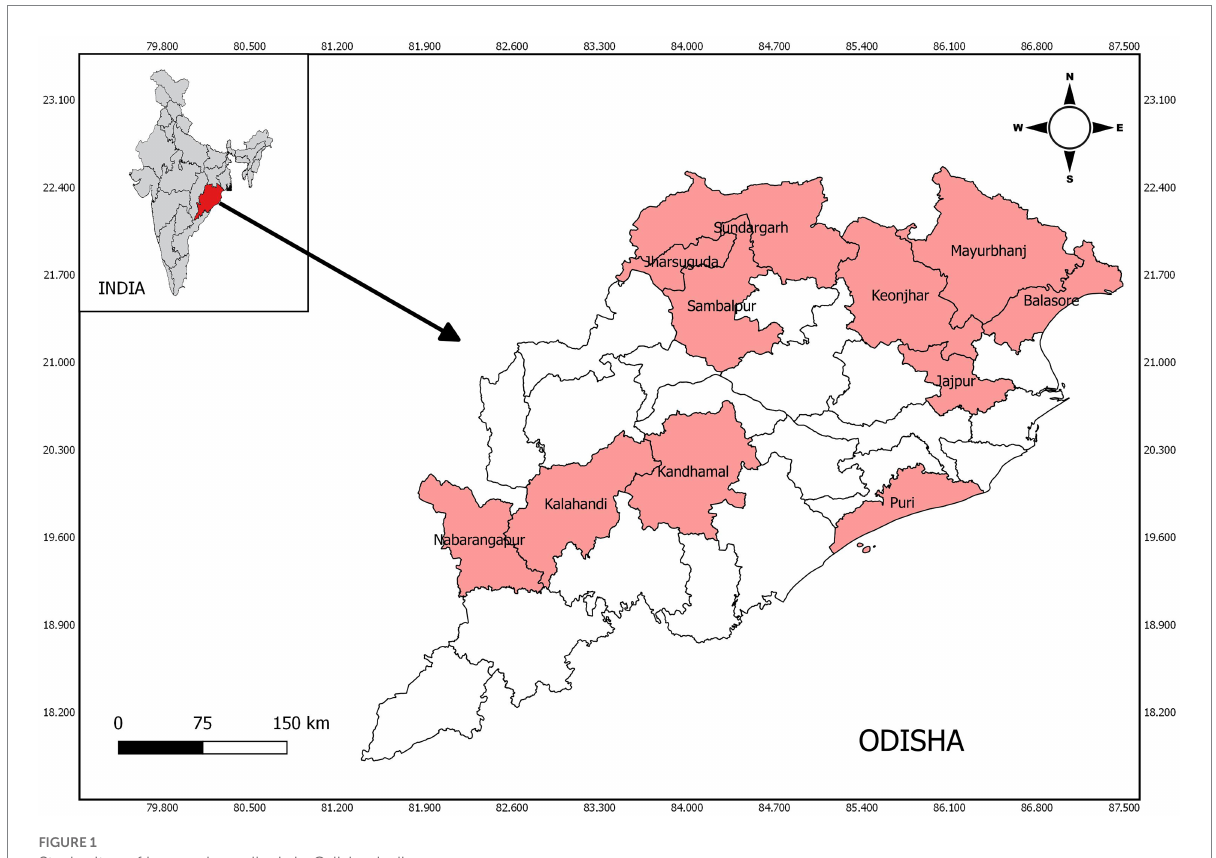
FIGURE 1 Study sites of human brucellosis in Odisha,